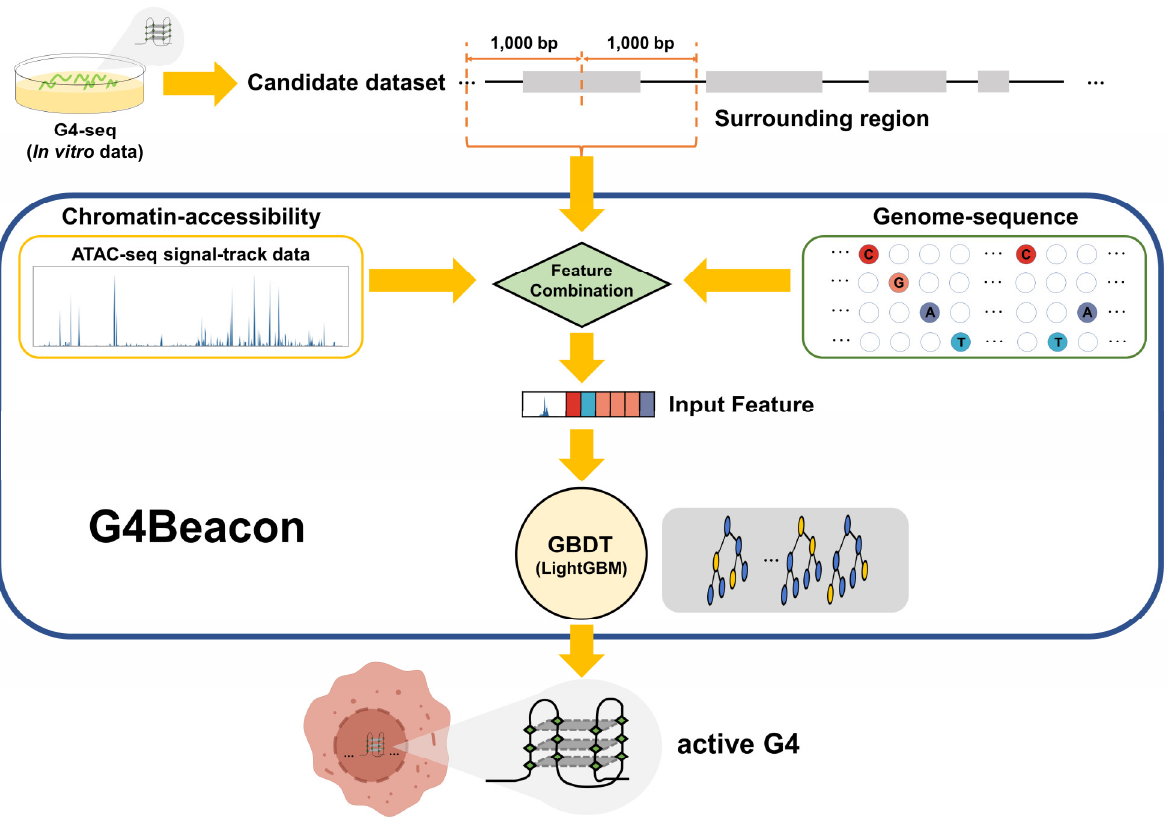
Figure 1. Overview of G4Beacon workflow. G4-seq data are employed as the candidate active G4 dataset. For each candidate sample (G4-seq entry), G4Beacon extends it into a region of 2000 bp length (surrounding region) and utilizes both ATAC-seq signal-track data and sequence data for feature selection and construction. The ATAC-seq feature is transformed into a float vector using the sliding-window method and the sequence feature is encoded using the ordinal categorical encoding method. All of these features are taken by our trained-GBDT model (implemented using LightGBM) as input for predicting whether the G4 will fold or not in the specific cellular environment.